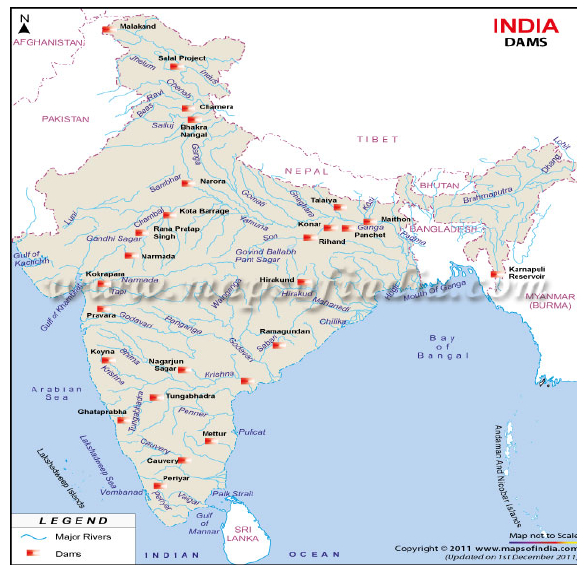
Figure 3: Dams and Rivers map of India Together, the trans-boundary rivers of North India